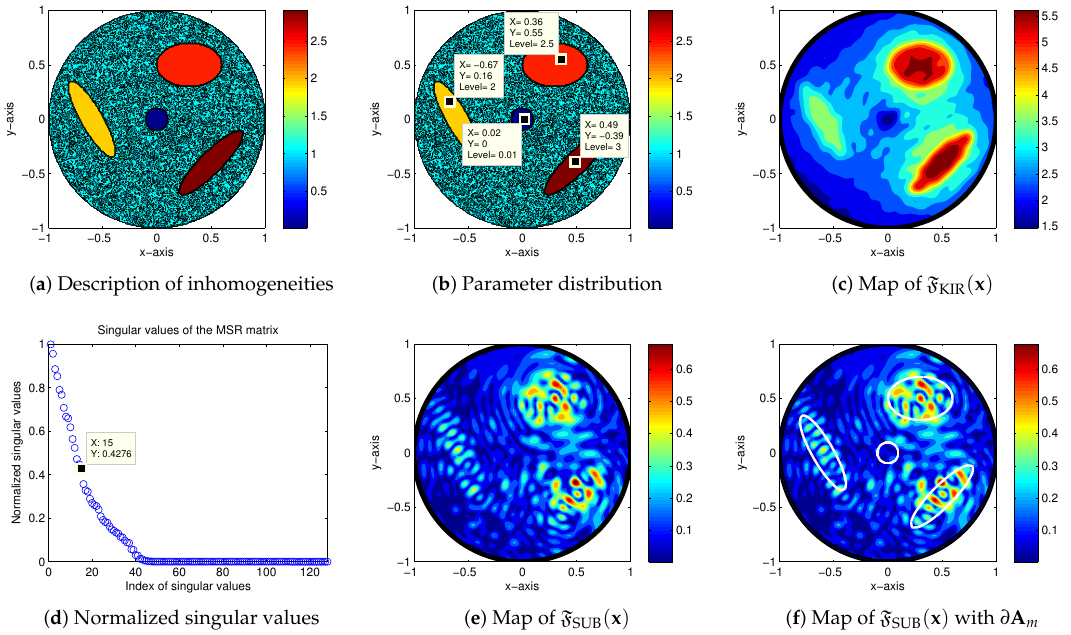
Figure 6. (Example 5) Imaging results for extended targets embedded in an inhomogeneous